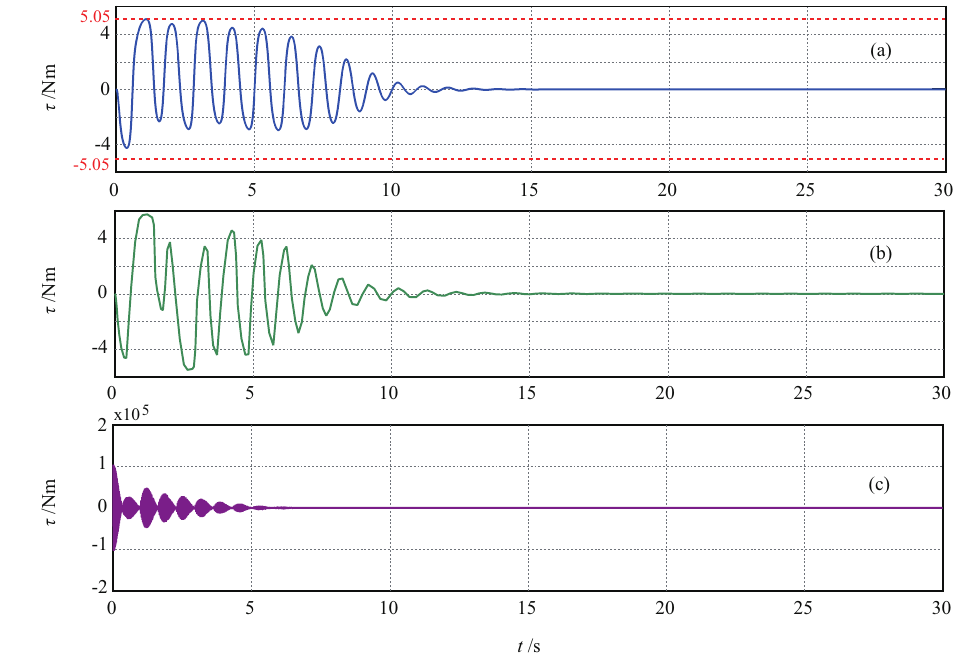
Figure 4. Time response curves of the control torque τ . ( a ) Proposed method; ( b ) Method in [34]; ( c ) Method in